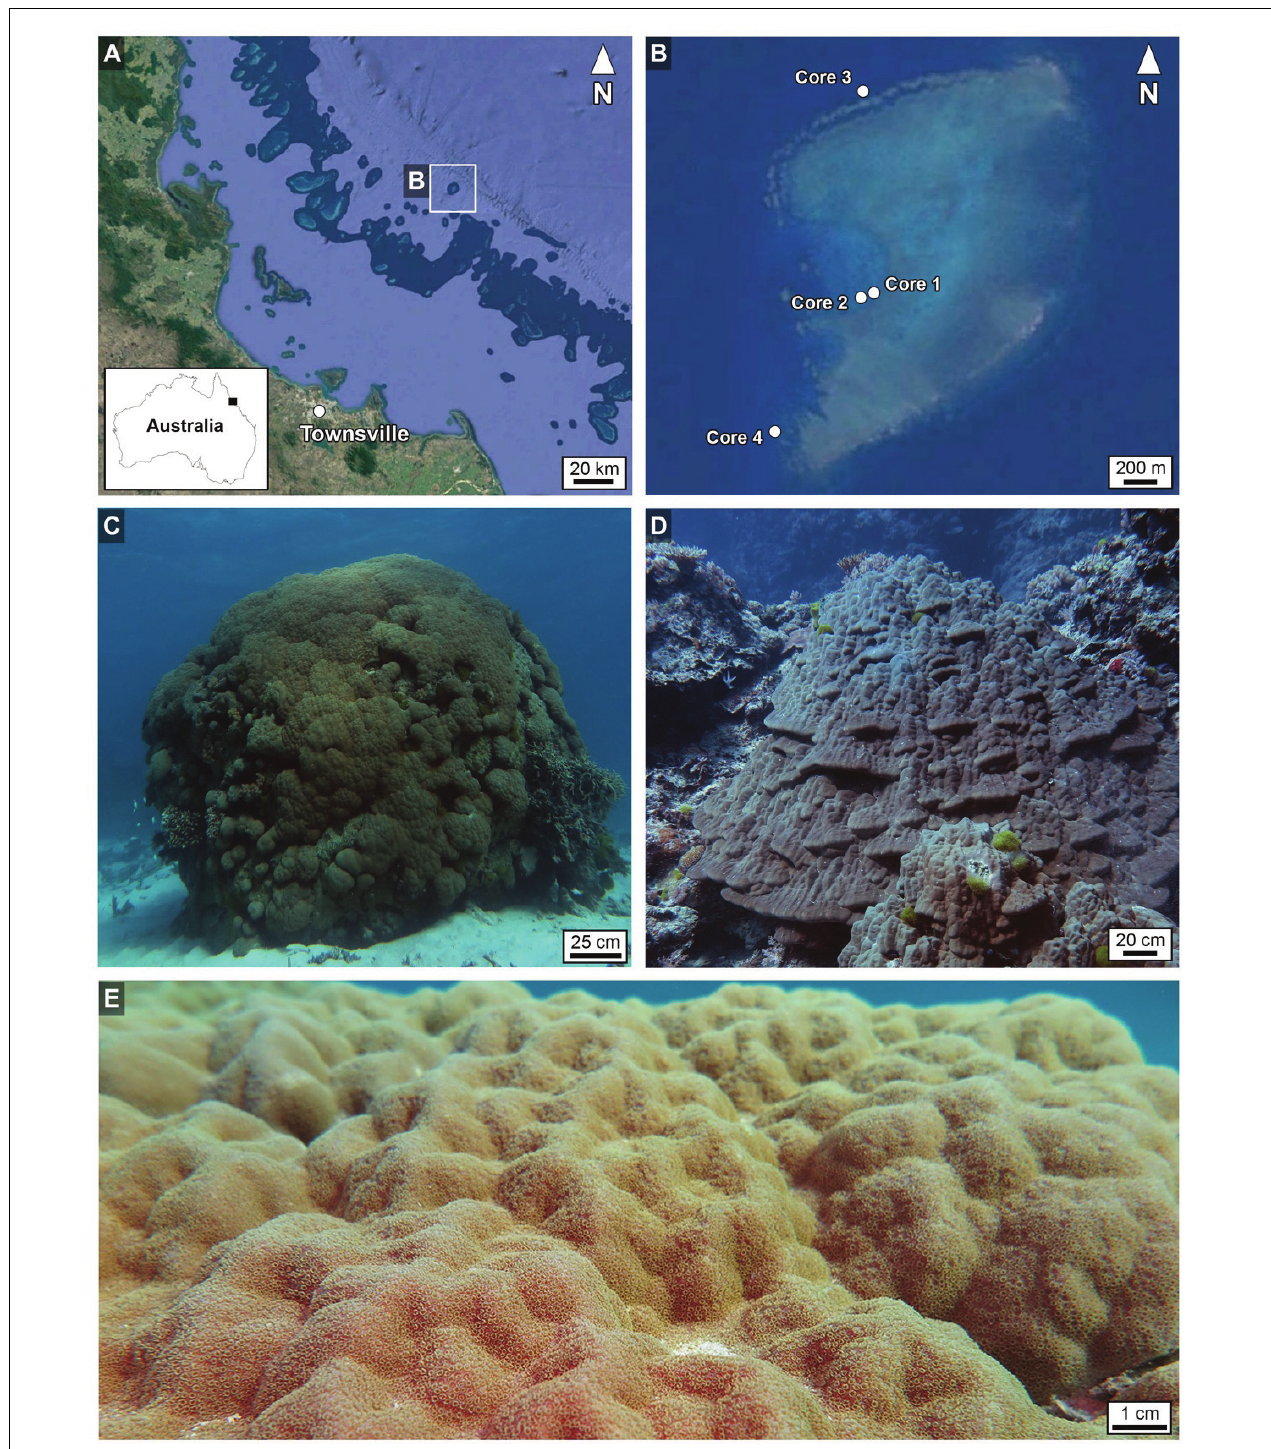
FIGURE 1 | (A,B) Geographic location of Myrmidon Reef in northeast Queensland, Australia (CSIRO), showing specific locations of Porites coralla from which Cores 1–4 were collected. (C,D) Field photographs of the coralla from which Core 2 (C) and Core 3 (D) were drilled. (E) Field photograph of the bumpy living tissue-covered growing surface of the Porites corallum shown in (C) . The images (A,B) are made in a ArcGIS software (Economic and Social Research Institute, ArcGIS version 10.5) at the Department of Geography and Geographic Information Science, University of Illinois at Urbana-Champaign; https://www.geog.illinois.edu/ giscience). The map inset of the Australian coastline in image A was traced from open source Google Maps (https://www.google.com/maps/ @-25.2072384,138.5384141,4.74z) using Canvas Draw 4 for Mac.